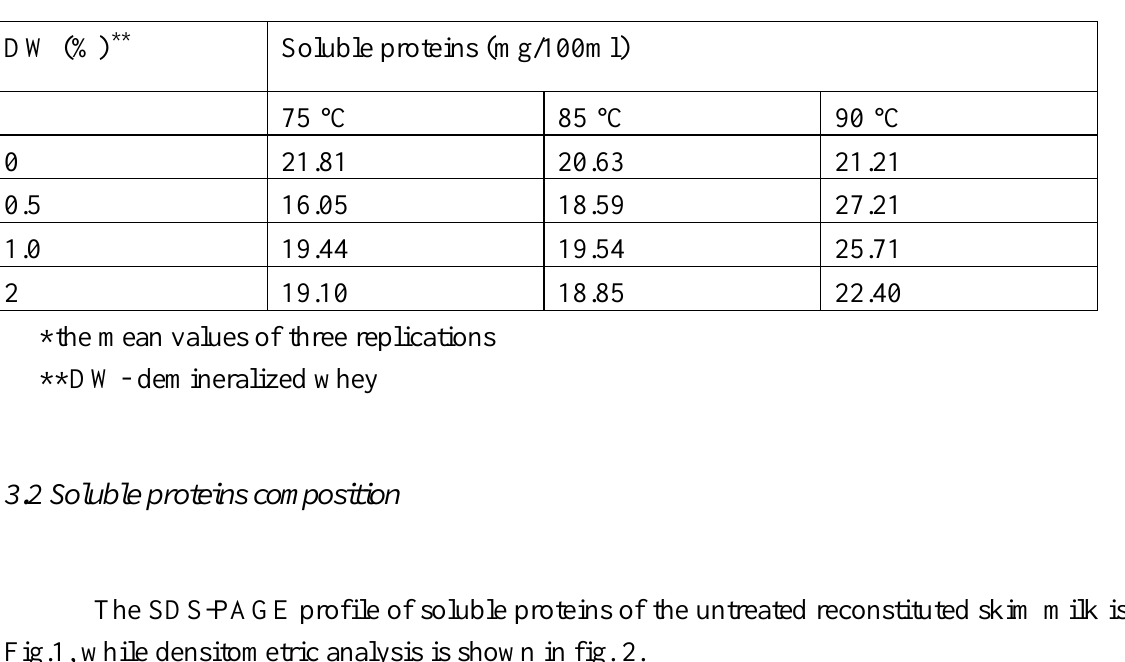
Table 1 . Soluble protein content of heat-treated reconstituted skim